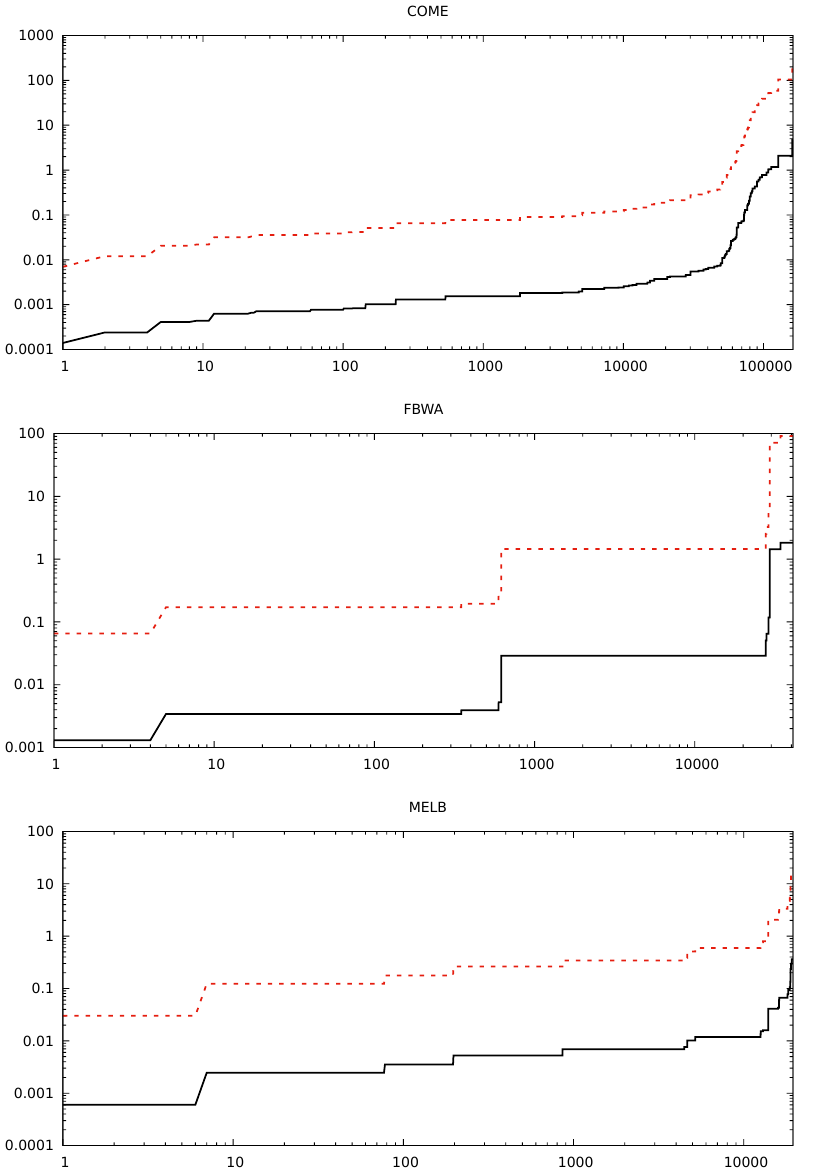
Figure 5. Relative error of APX -1024 as a function of rank position for the graphs COME , FBWA , and MELB . In particular, the horizontal axis corresponds to the position of a node in the exact ranking, while the black (respectively, red dashed) plot indicates the maximum average (respectively, maximum) RE (over 50 experiments) of all the nodes up to that position. The plot is in loglog-scale. Note that there are groups of nodes with very similar relative error: as a result of a preliminary analysis of this phenomenon, we noticed that this is due to the existence of several small cliques disconnected from the rest of the